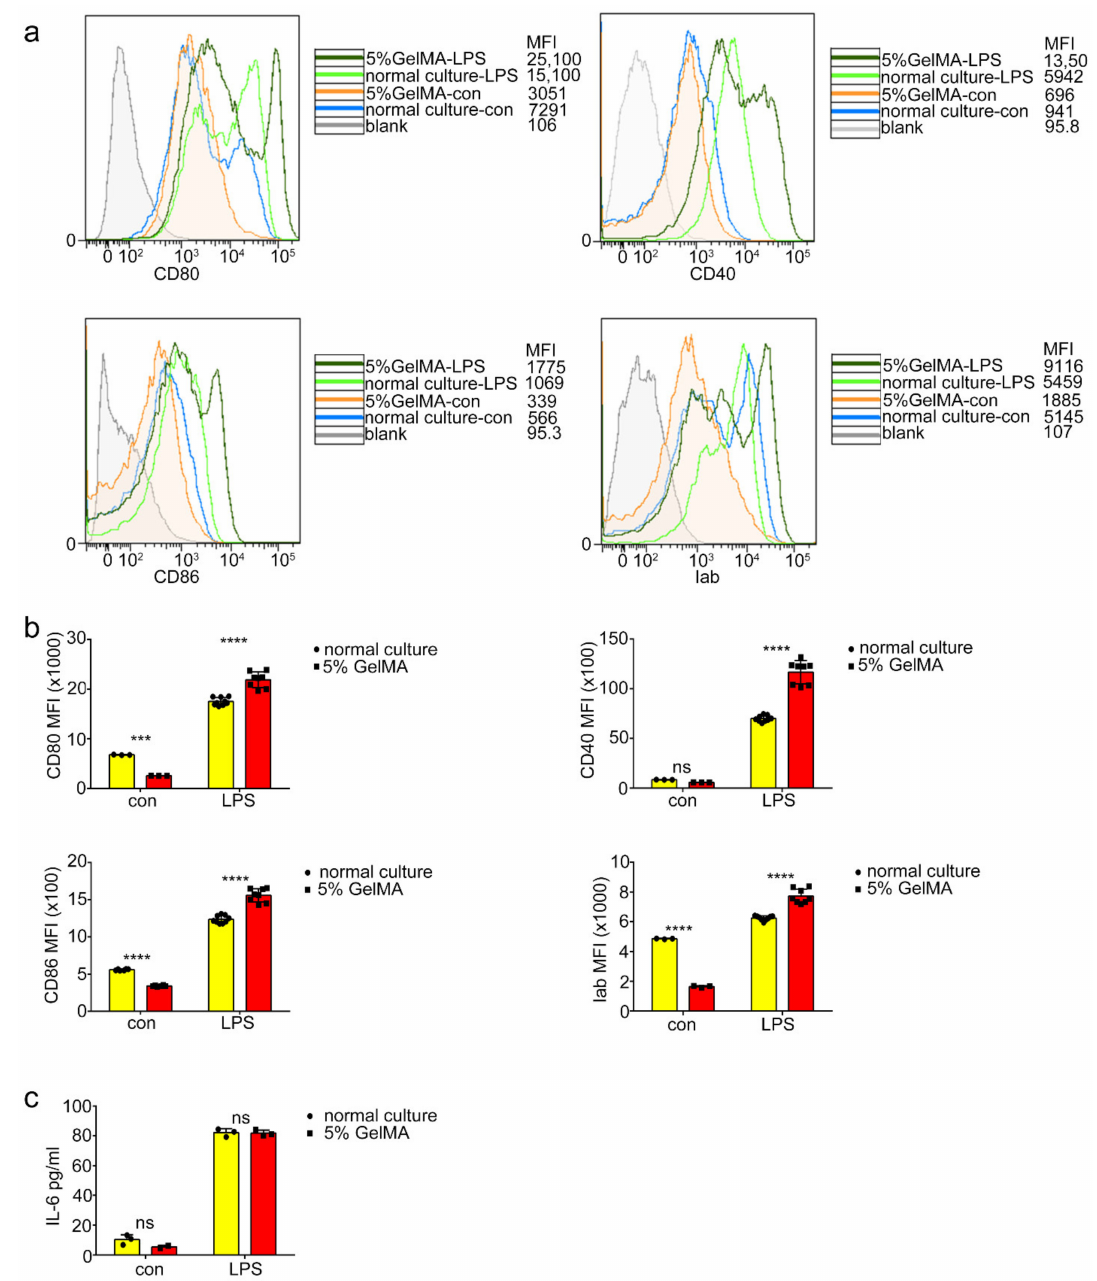
Figure 4. BMDCs cultured on 5% GelMA-30 with the low expression level of costimulatory molecules could be well activated by LPS as well. ( a , b ) BMDCs by CCHS or on normal condition,